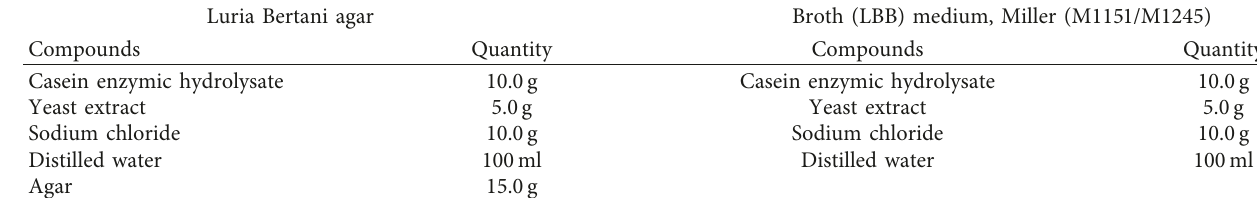
Table 3: Preparation of media for B. subtilis